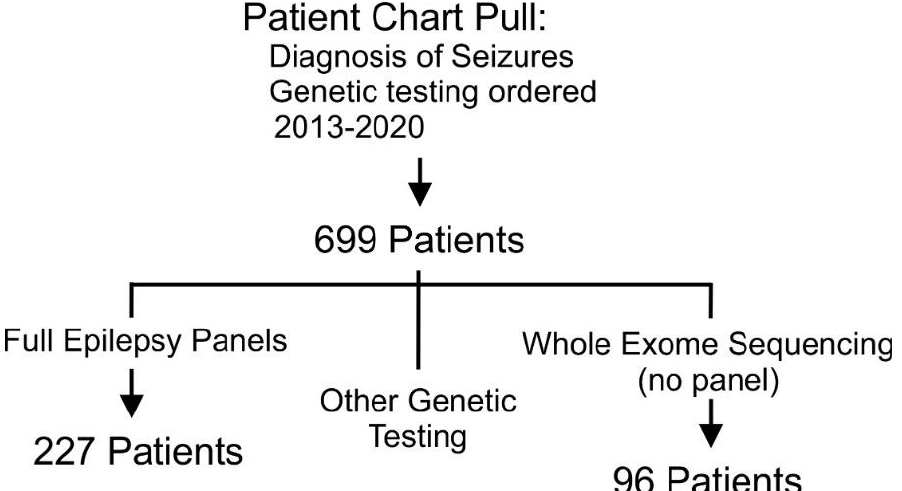
Figure 1. Methods. Parameters of medical record identification from our electronic medical record system (EPIC Systems). Charts were selected based on ICD diagnostic codes including ‘seizures’ or ‘epilepsy’ and any order under ‘genetic testing’. We queried our electronic records from 2013 to the end of 2020. 699 patients were identified in the original chart pull, 227 of whom met our inclusion criteria with a multi-gene epilepsy panel sent and resulted and 96 of whom had whole exome sequencing without an epilepsy panel. Table 1. Summary of results of epilepsy panel cohort.